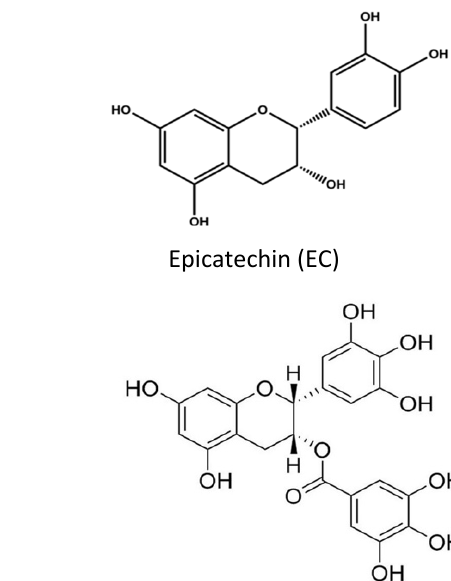
Figure 8. Structure of Theaflavin and Thearubigin in black tea.